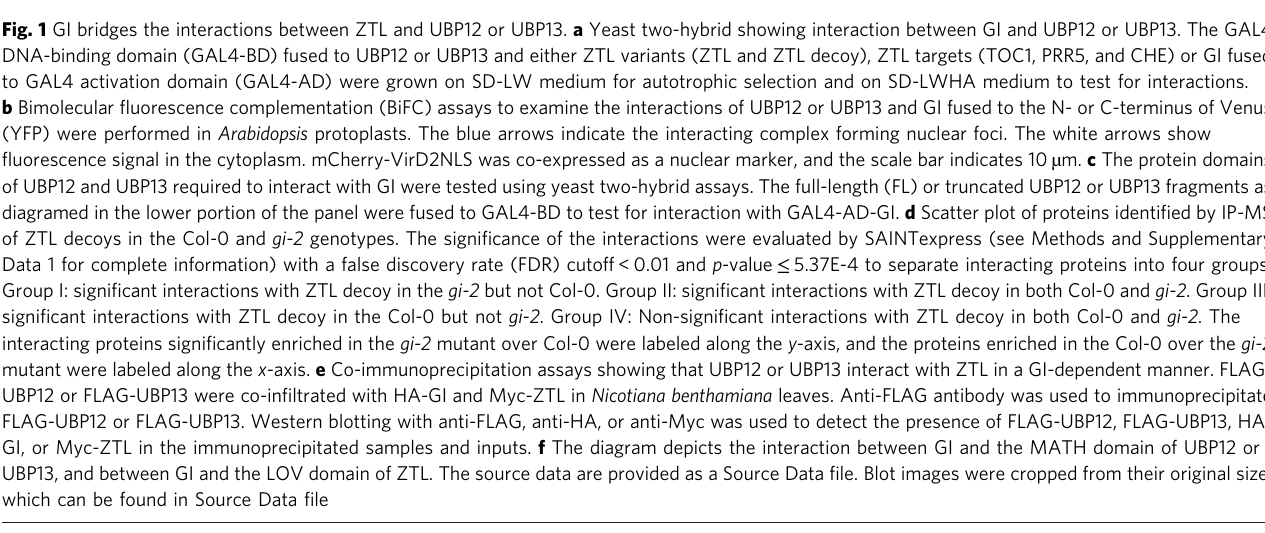
Fig. 1 GI bridges the interactions between ZTL and UBP12 or UBP13. a Yeast two-hybrid showing interaction between GI and UBP12 or UBP13. The GAL4 DNA-binding domain (GAL4-BD) fused to UBP12 or UBP13 and either ZTL variants (ZTL and ZTL decoy), ZTL targets (TOC1, PRR5, and CHE) or GI fused to GAL4 activation domain (GAL4-AD) were grown on SD-LW medium for autotrophic selection and on SD-LWHA medium to test for interactions. b Bimolecular fl uorescence complementation (BiFC) assays to examine the interactions of UBP12 or UBP13 and GI fused to the N- or C-terminus of Venus (YFP) were performed in Arabidopsis protoplasts. The blue arrows indicate the interacting complex forming nuclear foci. The white arrows show fl uorescence signal in the cytoplasm. mCherry-VirD2NLS was co-expressed as a nuclear marker, and the scale bar indicates 10 µ m. c The protein domains of UBP12 and UBP13 required to interact with GI were tested using yeast two-hybrid assays. The full-length (FL) or truncated UBP12 or UBP13 fragments as diagramed in the lower portion of the panel were fused to GAL4-BD to test for interaction with GAL4-AD-GI. d Scatter plot of proteins identi fi ed by IP-MS of ZTL decoys in the Col-0 and gi-2 genotypes. The signi fi cance of the interactions were evaluated by SAINTexpress (see Methods and Supplementary Data 1 for complete information) with a false discovery rate (FDR) cutoff < 0.01 and p -value ≤ 5.37E-4 to separate interacting proteins into four groups. Group I: signi fi cant interactions with ZTL decoy in the gi-2 but not Col-0. Group II: signi fi cant interactions with ZTL decoy in both Col-0 and gi-2 . Group III: signi fi cant interactions with ZTL decoy in the Col-0 but not gi-2 . Group IV: Non-signi fi cant interactions with ZTL decoy in both Col-0 and gi-2 . The interacting proteins signi fi cantly enriched in the gi-2 mutant over Col-0 were labeled along the y -axis, and the proteins enriched in the Col-0 over the gi-2 mutant were labeled along the x -axis. e Co-immunoprecipitation assays showing that UBP12 or UBP13 interact with ZTL in a GI-dependent manner. FLAG- UBP12 or FLAG-UBP13 were co-in fi ltrated with HA-GI and Myc-ZTL in Nicotiana benthamiana leaves. Anti-FLAG antibody was used to immunoprecipitate FLAG-UBP12 or FLAG-UBP13. Western blotting with anti-FLAG, anti-HA, or anti-Myc was used to detect the presence of FLAG-UBP12, FLAG-UBP13, HA- GI, or Myc-ZTL in the immunoprecipitated samples and inputs. f The diagram depicts the interaction between GI and the MATH domain of UBP12 or UBP13, and between GI and the LOV domain of ZTL. The source data are provided as a Source Data fi le. Blot images were cropped from their original size, which can be found in Source Data fi